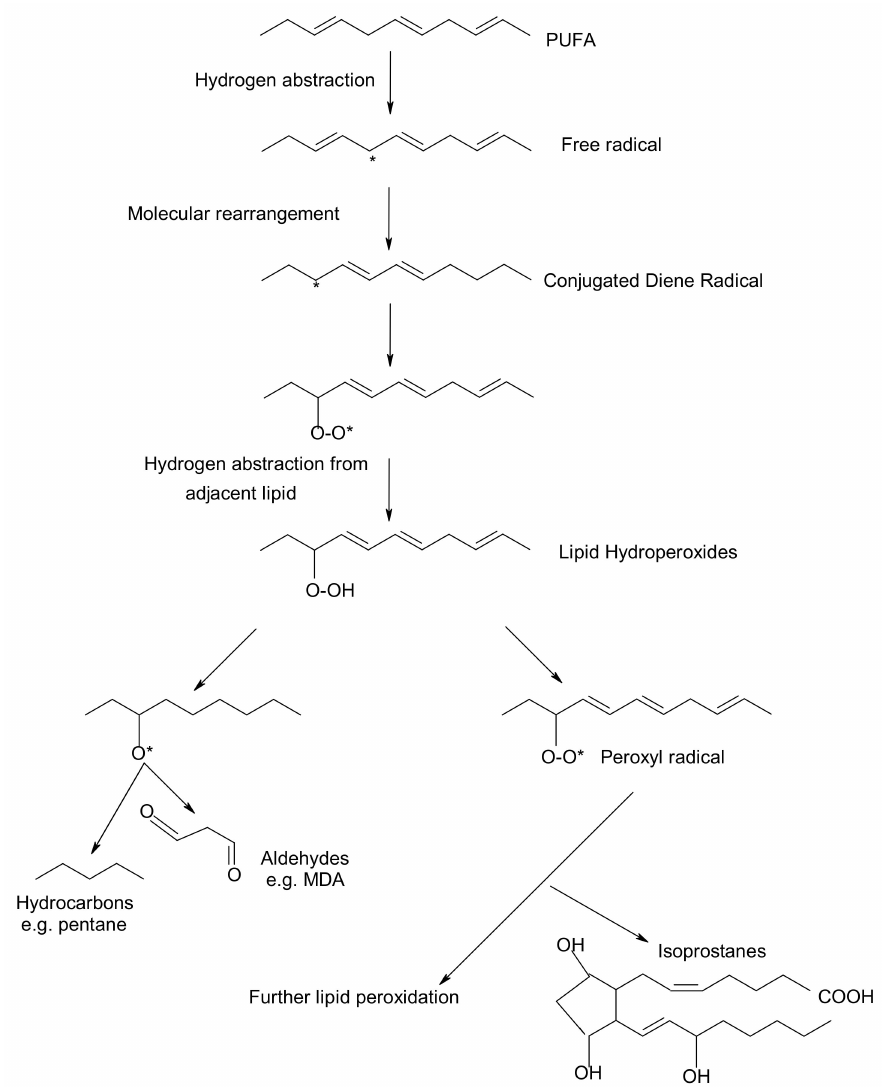
Figure 1. Overview of lipid peroxidation process and oxidative biomarkers (* indicates the presence of free